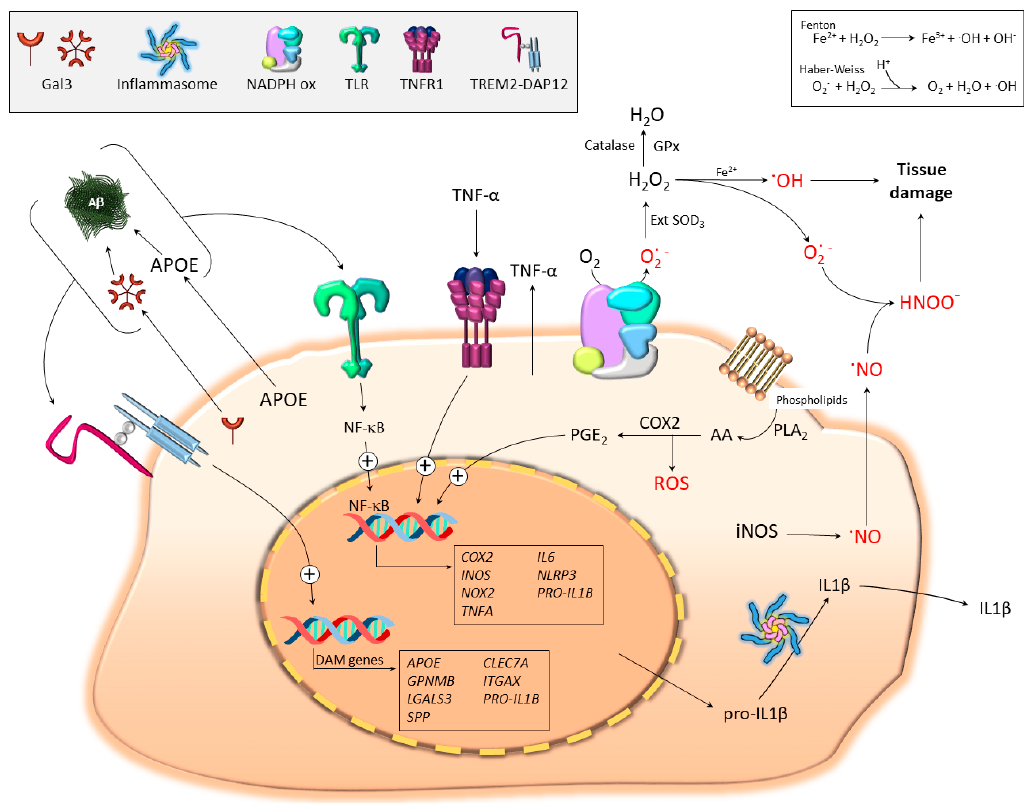
Figure 2. Pro-oxidant microglia under disease conditions. TLR signaling drives NF- κ B activation and transcription of proinflammatory and pro-oxidant molecules including iNOS, COX2, NADPH oxidase (NOX2), TNF- α , and pro-IL-1 β . Assembly of NOX2 and ulterior activation constitutes an